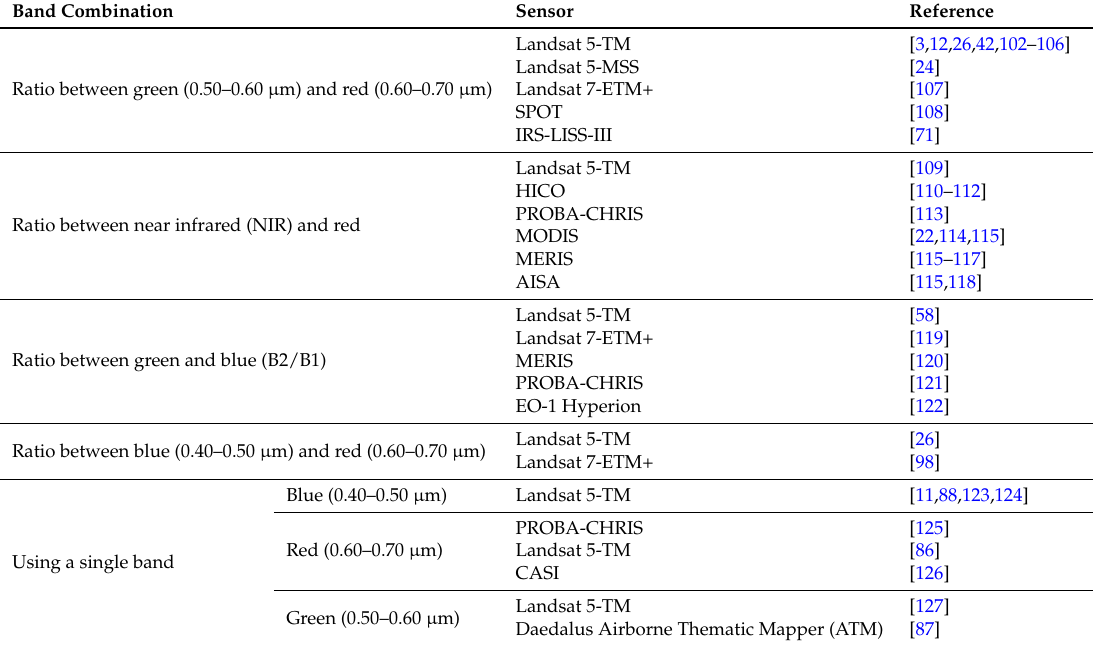
Table 5. Remotely measurements of chl- a using various spectral bands and their ratios. Band Combination Sensor